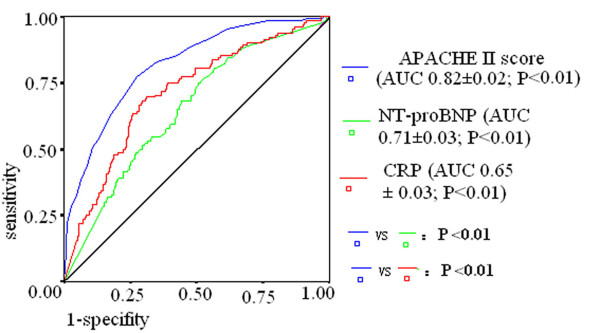
ROC curves for APACHE II score, CRP and NT-proBNP in prediction of ICU mortality. The area under the ROC curve (AUC) of NT-proBNP were larger than that of CRP or NT-proBNP (all P < 0.01).